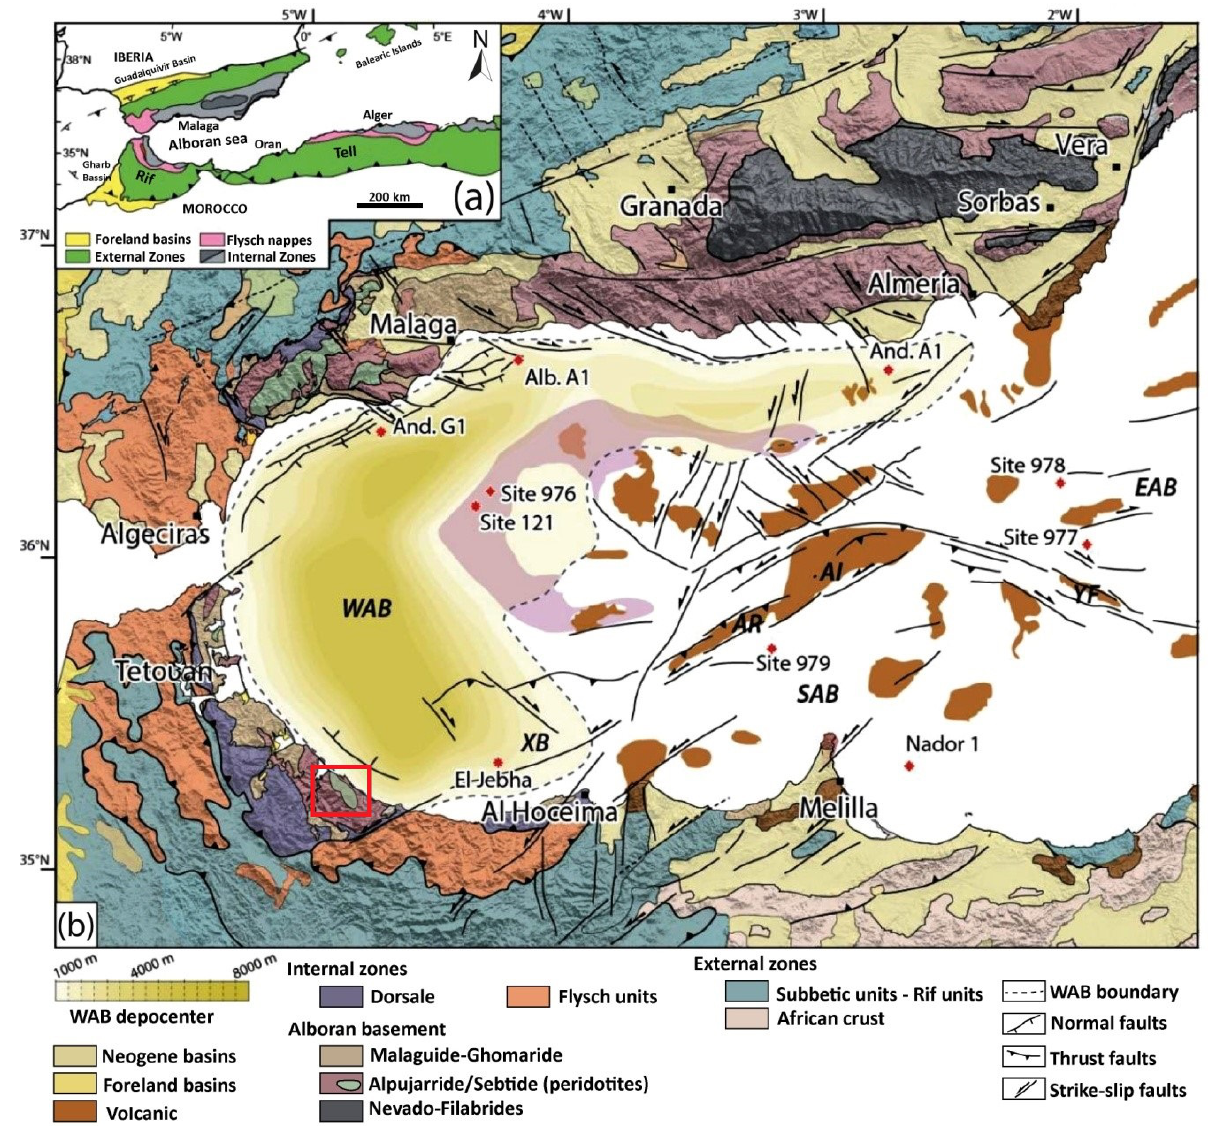
Figure 1. Geologic map of the Alboran domain in the Betic-Rif arc with the major tectonic features, modified after Do Couto et al. [1]. ( a ) Location of the studied mountain belt within the Gibraltar arc. ( b ) Detailed geologic and tectonic map of the chain, centered on the Rif and zooming on the Internal zones, with the location of the investigated area (open red box). ODP sites 976 to 979, DSDP site 121, and all industrial wells are also located offshore (And G1 = Andaluc í a-G1; Alb A1 = Albor á n-A1; And A1 = Andaluc í a-A1). AR = Alboran ridge; AI = Alboran Island; EAB = Eastern Alboran Basin; SAB = South Alboran Basin; WAB = western Alboran Basin; XB = Xauen bank; YF = Yusuf